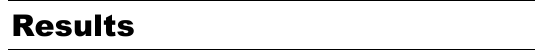
Table 1: Differences of Mean of parameters between two groups of patients. Variables